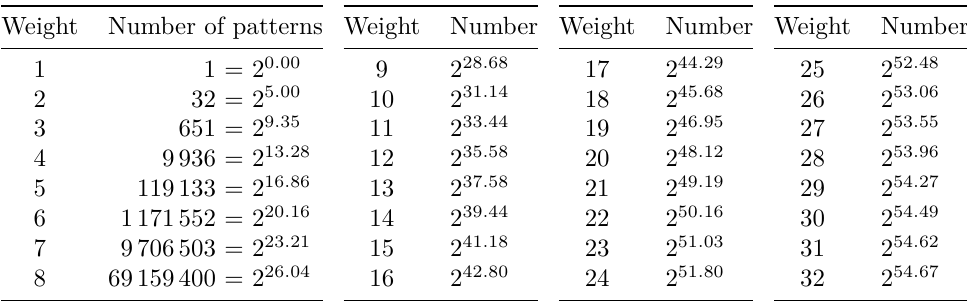
Table 5: Number of 64-bead necklaces with fixed weight. The numbers for